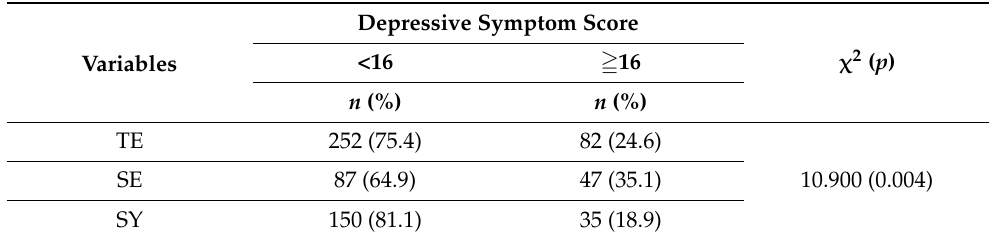
Table 2. The distribution of depressive symptom high and low risk group according to Sasang constitution. ( n = 653).